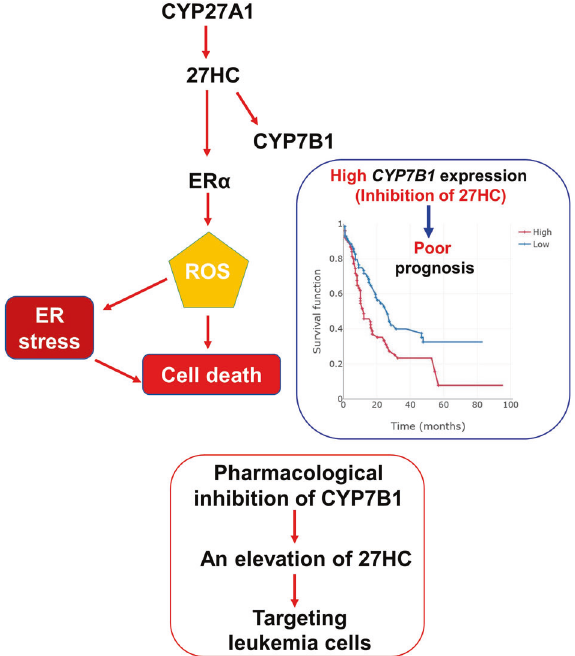
Fig. 6 Schematic model. 27HC is the most effective oxysterol in the circulatory system and hematological malignancies. 27HC increases the ROS response and induces apoptosis through the ER stress response pathway. Pharmacological inhibition of CYP7B1 (expected to have an elevation of 27HC) would potentially have fewer long- term hematological side effects, particularly when used in combina- tion with chemotherapy or radiation for the treatment of leukemia